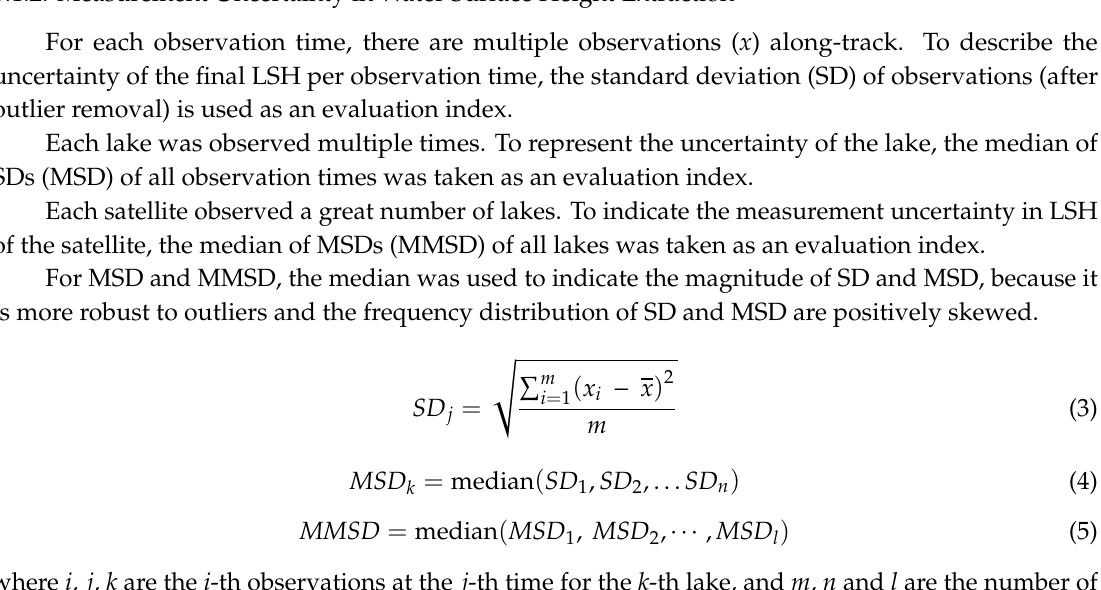
Figure 2. Workflow of lake surface height extraction from data acquired by the Ice, Cloud, and Land Elevation Satellite-2 (ICESat-2), Satellite for ARgos and ALtika (SARAL), and Ice, Cloud, and Land Elevation Satellite (ICESat) missions.